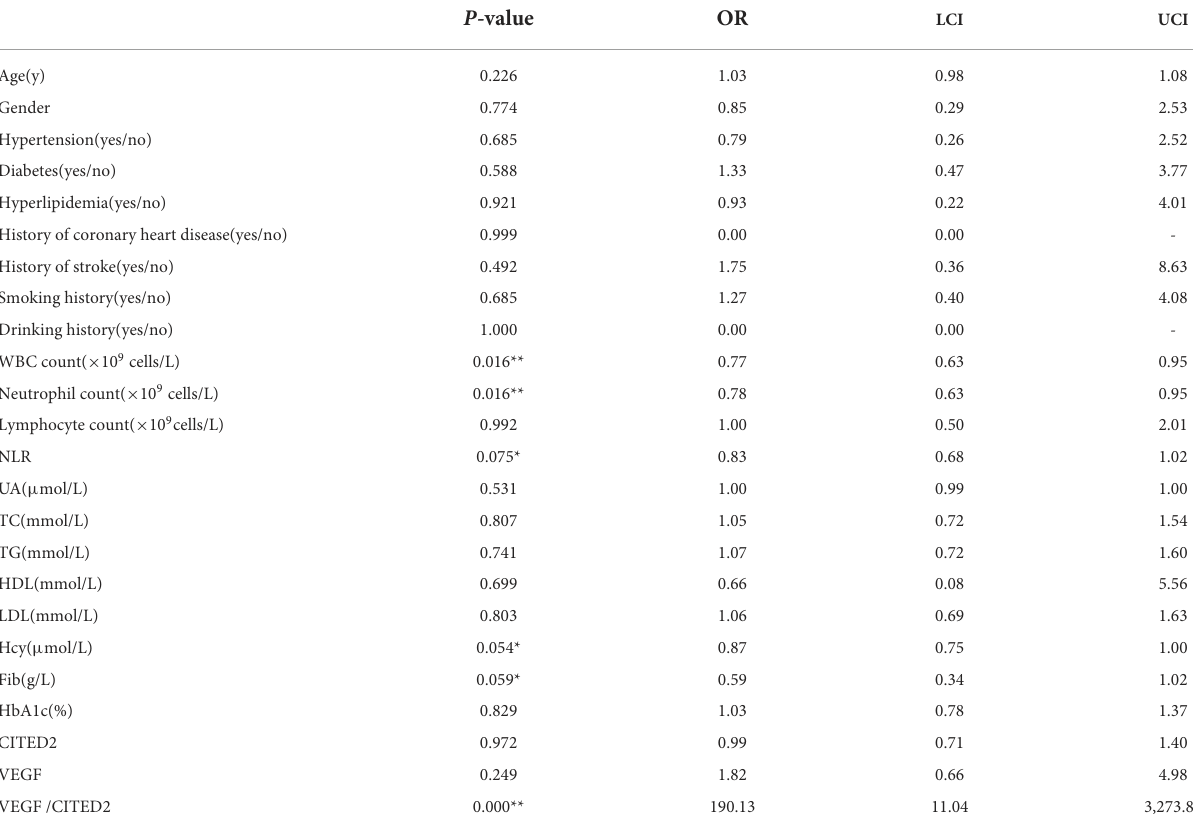
TABLE 4 Univariate logistic regression analysis of collateral circulation-related factors in